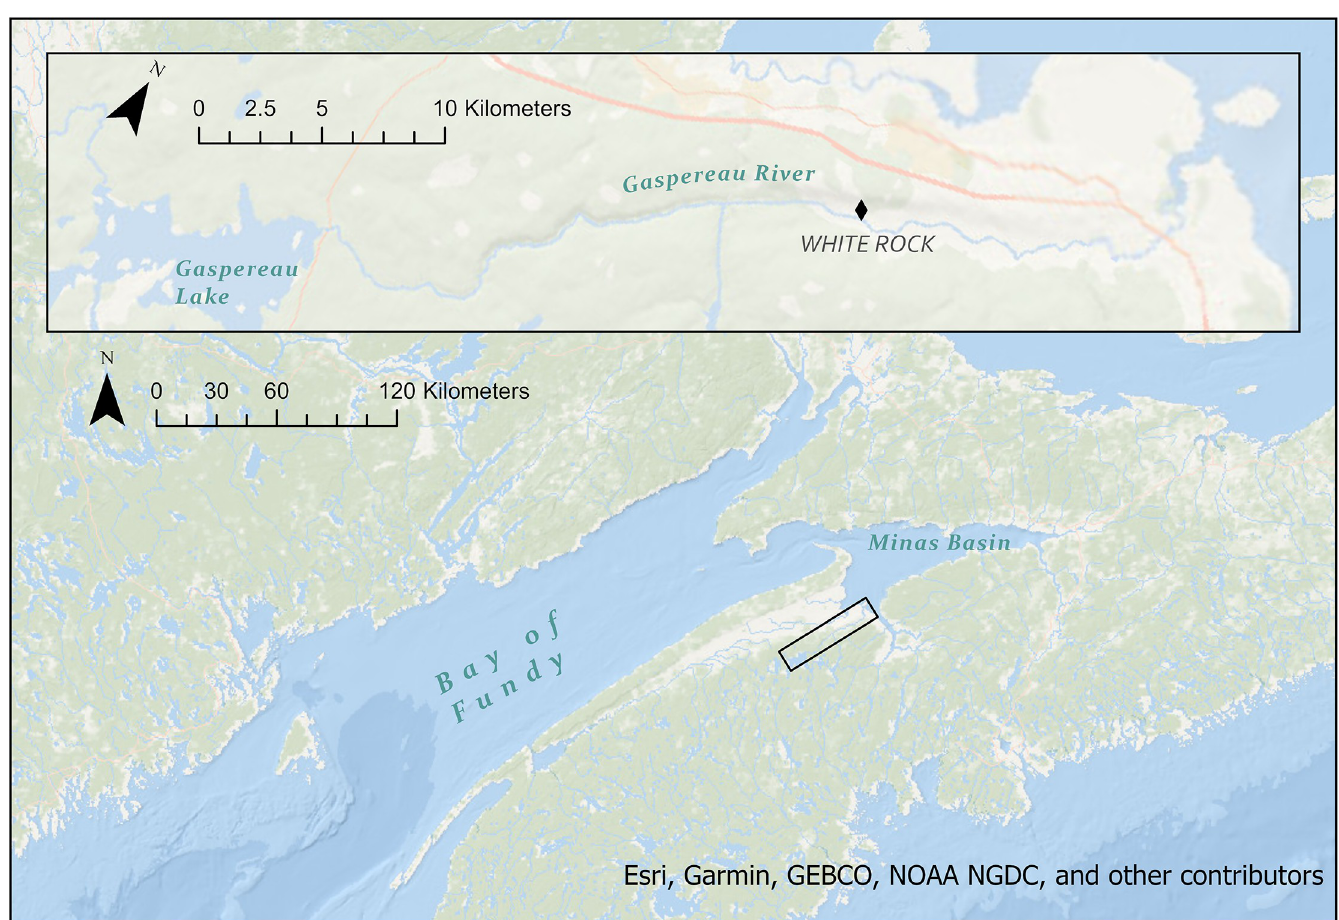
Fig 1. Map of study area, showing Minas Basin and an inset of Gaspereau River and Gaspereau Lake. The tagging site at White Rock Fish Ladder is designated by a black diamond.